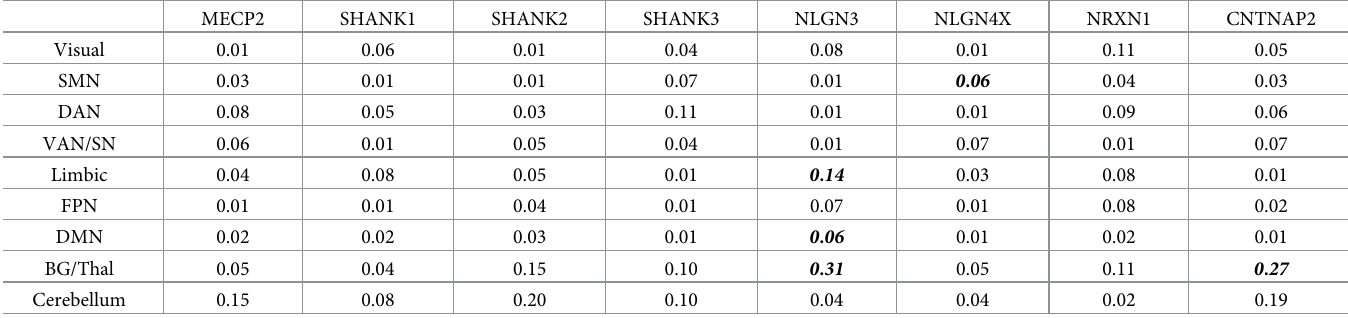
Table 2. The correlation value of gene expression related to areas of GM increase (ASD > TDCs) in Yeo’s [57] and Brainnetome’s [58] resting-state functional networks. MECP2 SHANK1 SHANK2 SHANK3 NLGN3 NLGN4X NRXN1